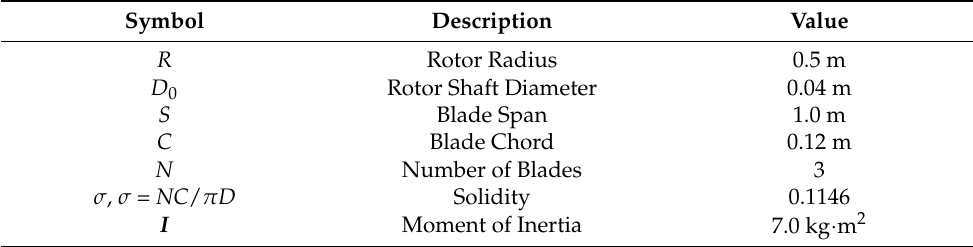
Table 1. Detailed parameters of VATT.